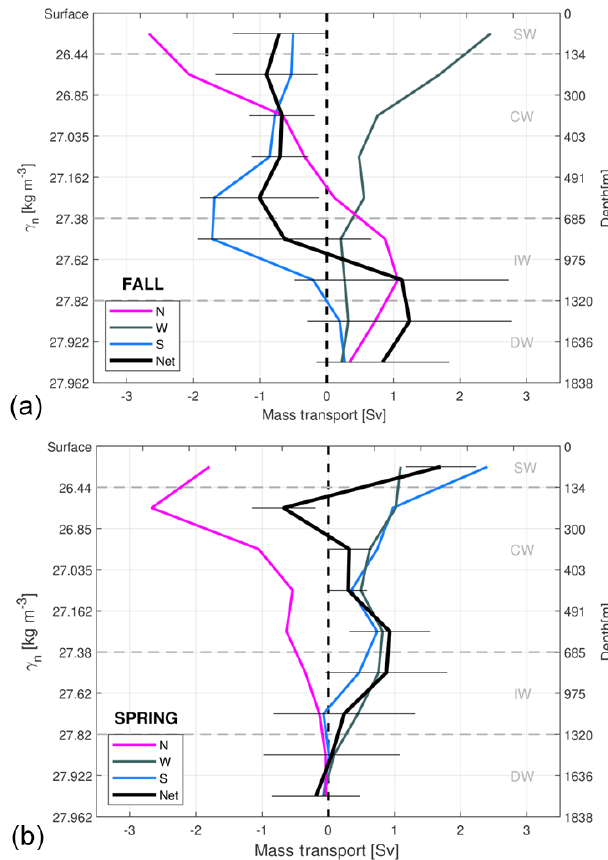
Figure 13. Accumulated mass transports per transect at the north (N, magenta line), west (W, dark grey line) and south (S, blue line) transects during fall (a) and spring (b) . See Table 2 for the γ n val- ues bounding every water layer. Negative–positive values indicate inward–outward transports as in Fig. 12. Mass conservation in the whole domain is shown by the black line. The horizontal bars rep- resent the uncertainties estimated by the